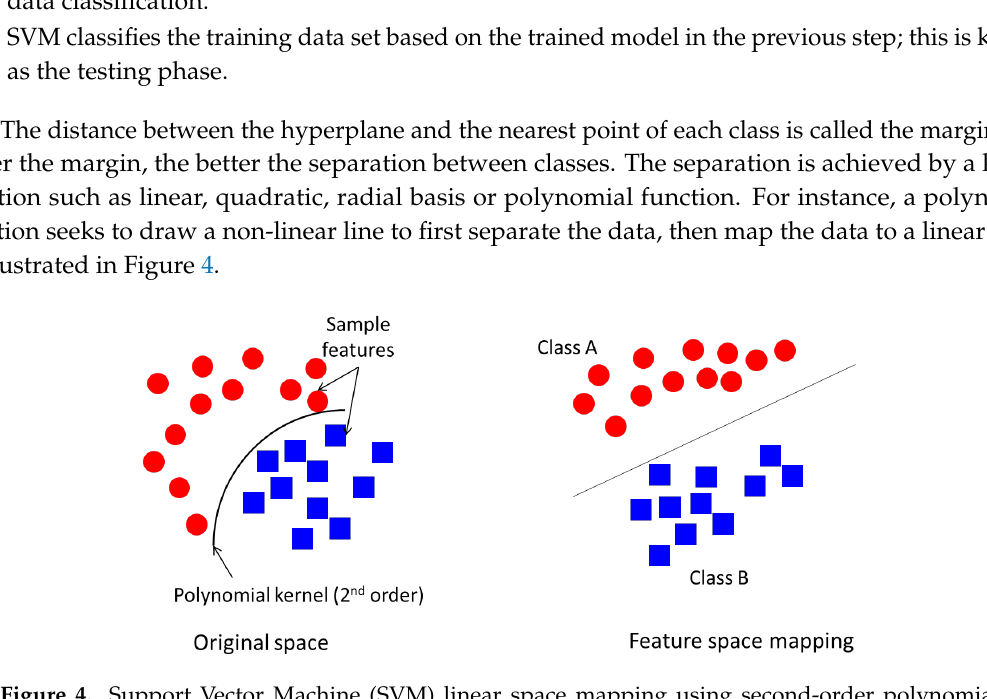
Figure 4. Support Vector Machine (SVM) linear space mapping using second-order polynomial kernel